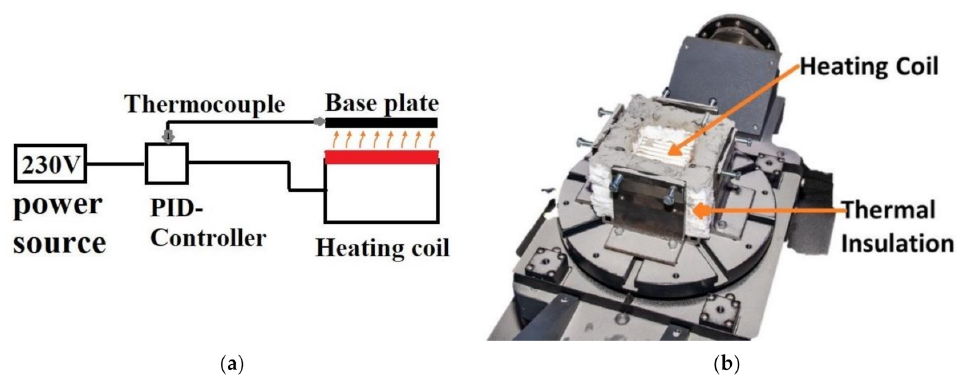
Figure 1. ( a ) Schematic diagram of heating system ( b ) Preheating setup. InssTek MX-600 utilizes powder as the feedstock material. A laser head has multiple concentric cones, which provide passage for powder and shield gas flow. The powder is directed to the laser point contact with the base plate, where it generates the melt